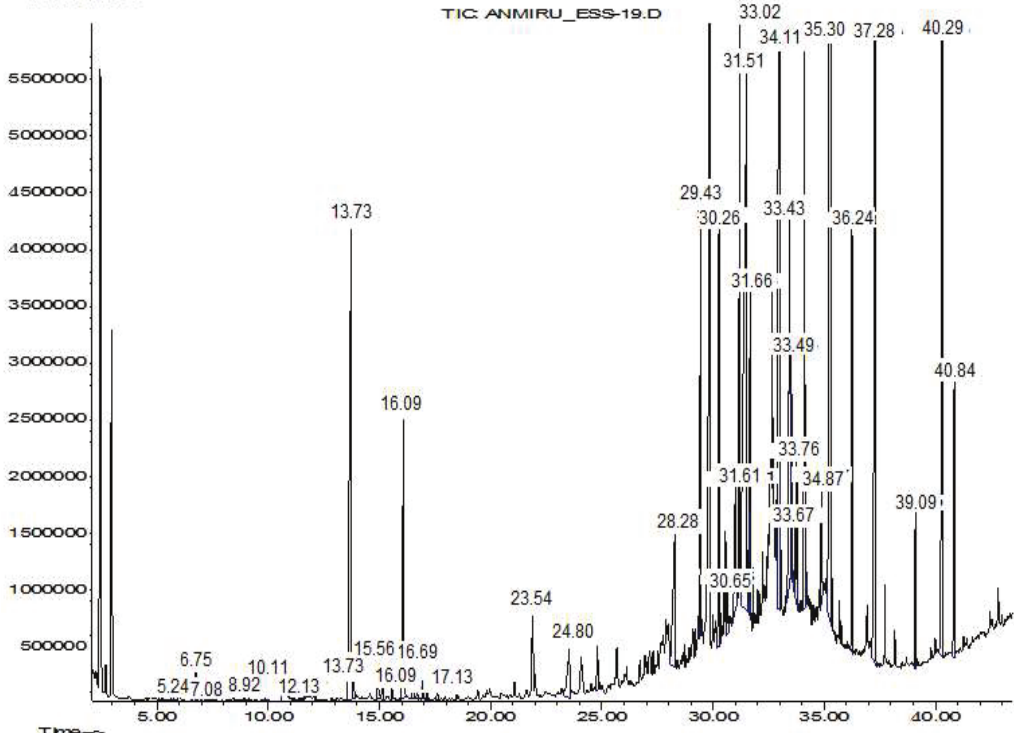
Fig. 2. Gas chromatogram of the components of the essential oil of flowers Crataegus monogyna L.